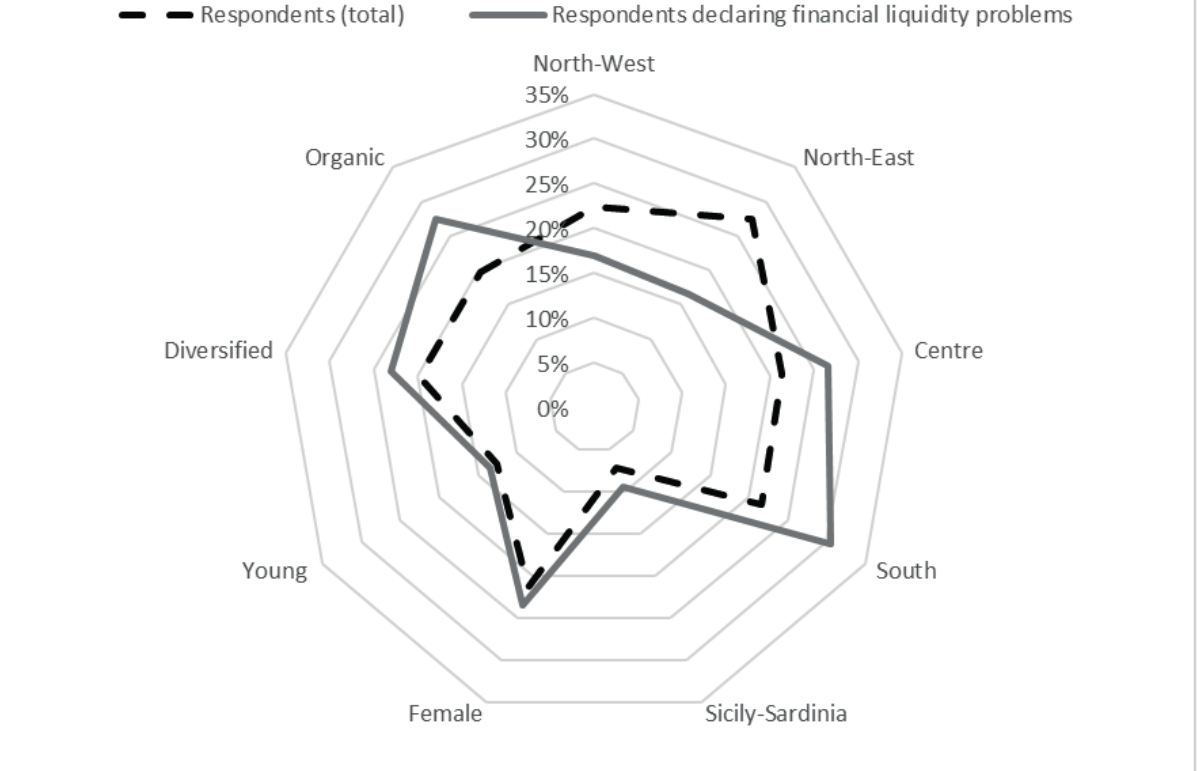
Figure 5. Focus on fi nancial liquidity problems. Source: own elaboration on collected